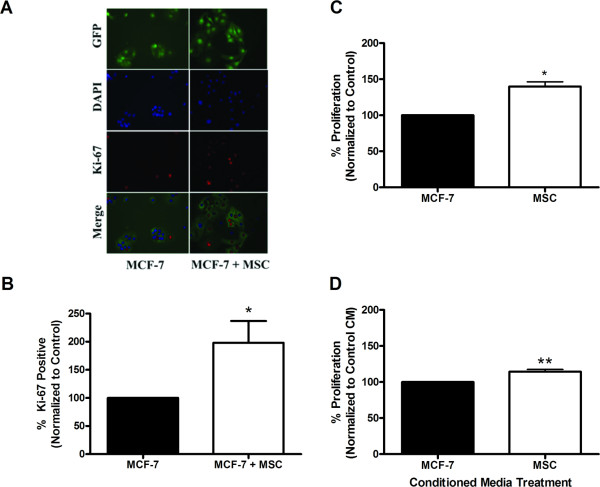
hMSCs enhance MCF-7 cell proliferation. (A) MCF-7-GFP cells cultured with or without hMSCs over 72 hours. Cells were fixed and stained with anti-Ki-67 (red) and nuclei were counter stained with DAPI (blue). Representative images of MCF-7 cells cultured alone (left) or with hMSCs (right) at 400×. (B) Quantification of GFP cells positive for Ki-67 staining from 10 fields of view per treatment. Data is represented as percent positive MCF-7 cells as compared to total number of MCF-7 cells normalized to MCF-7 control group. (C) MCF-7 cells were seeded in the lower chamber of a 24-well plate and MCF-7 cells (control) or hMSCs were seeded on the upper transwell insert. After 7 days of culture, inserts were removed and MTT was added to each well. After 4 hours, cells were solubilized and absorbance read. (D) MCF-7 cells were treated with MCF-7 (control) or hMSC conditioned media for 24 hours. After 4 hours of MTT treatment, cells were solubilized and absorbance read. All data are represented as percent proliferation normalized to control treated cells ± SEM, (* p < 0.05, *** p < 0.001).